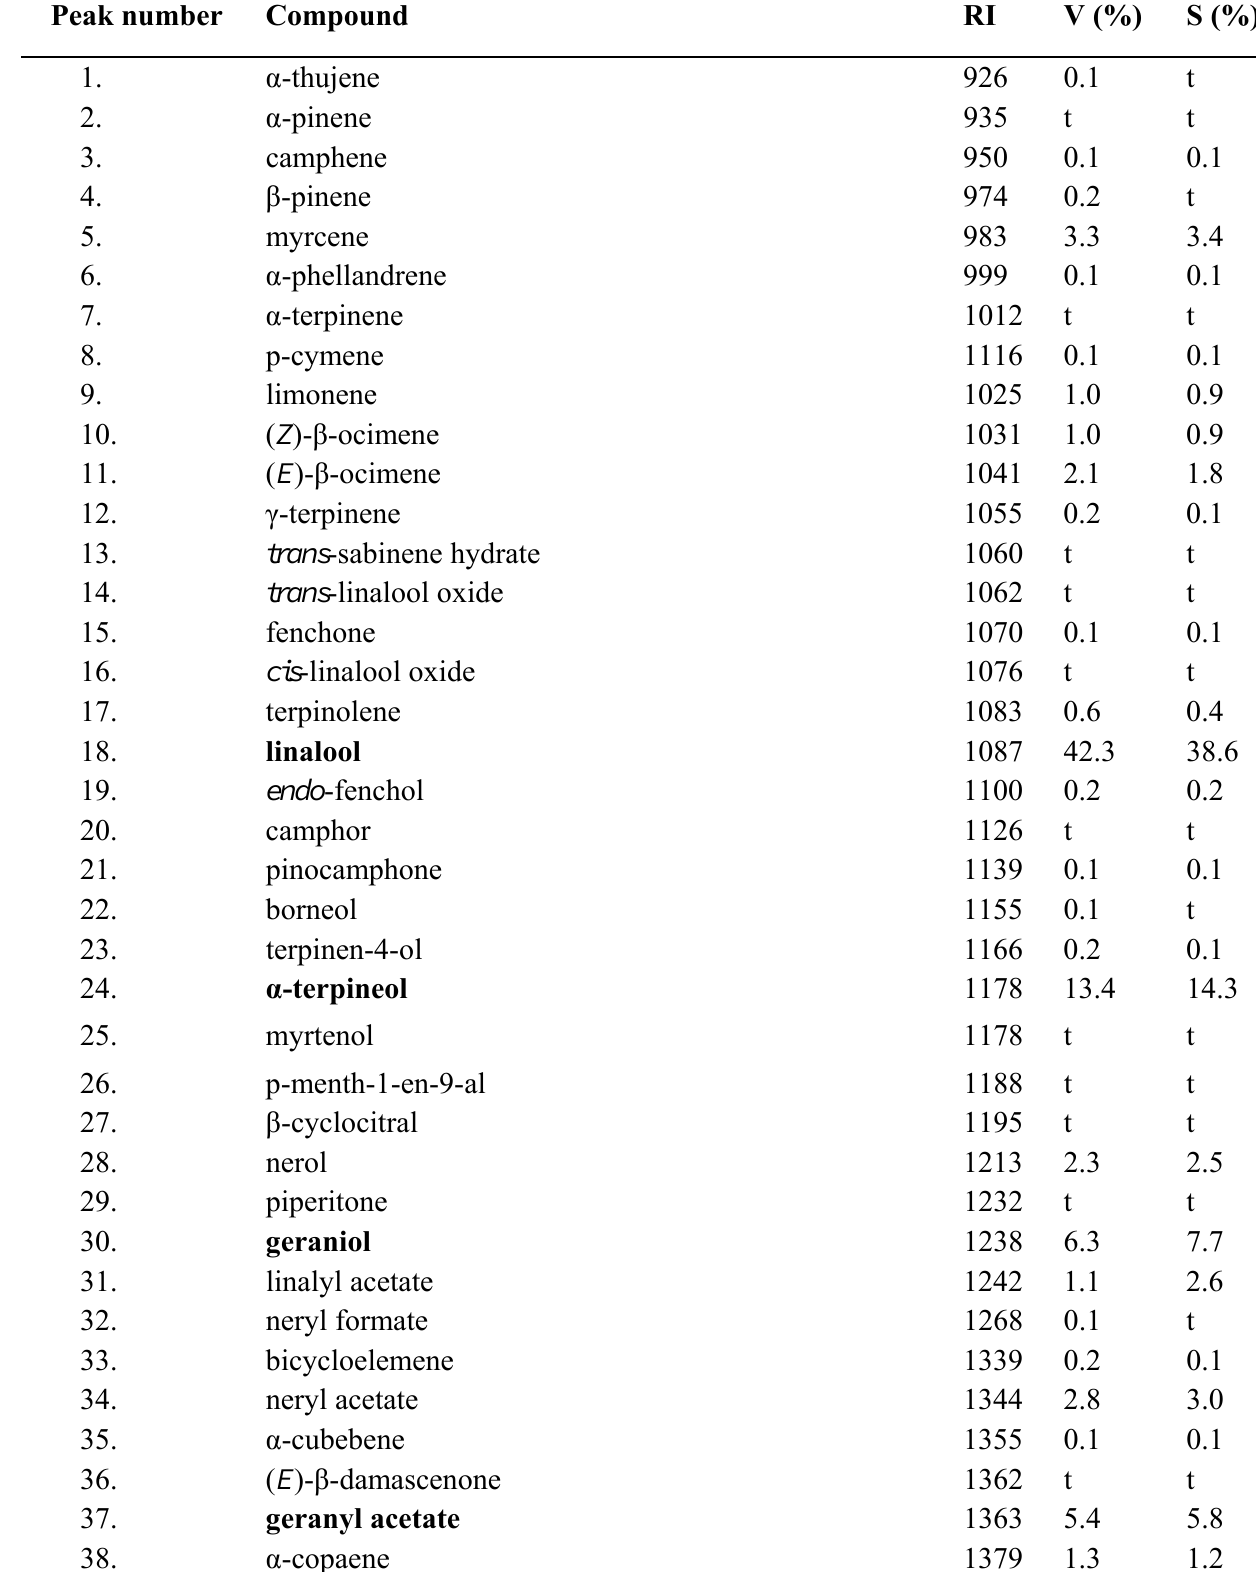
Table 1. Constituents of essential oils from in vitro / in vivo Salvia sclarea plants. Peak